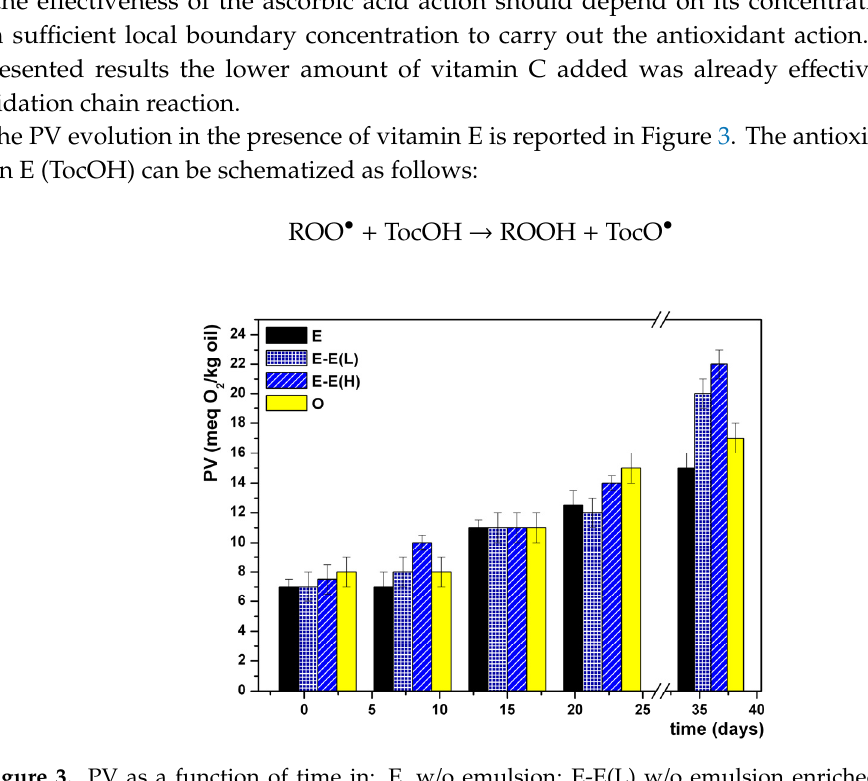
Figure 3. PV as a function of time in: E, w / o emulsion; E-E(L) w / o emulsion enriched with low concentration of vitamin E; E-E(H) w / o emulsion enriched with high concentration of vitamin E; O, oil (bars represent standard deviation of mean values).